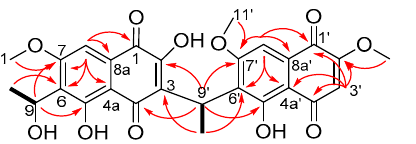
Figure 4. Selected COSY (solid line) and HMBC (arrows) correlations for 1 . The antimicrobial activity of 1 – 3 and 5 was evaluated against a panel of Gram-positive (methicillin-resistant S. aureus ) and Gram-negative ( Pseudomonas aeruginosa , E. coli , K. pneumoniae and Acinetobacter baumanii ) bacteria and two fungal strains ( Candida albicans and Cryptococcus neoformans ) (Table 2). The antimicrobial activity of pramanicin A ( 4 ) was not investigated in the present study due to lack of sample; however, the antifungal activity of the natural product has been previously reported [15]. Both neofusnaphthoquinone B ( 1 ) and monomer 2 exhibited activity against MRSA with 1 exhibiting more potent activity than 2 . Interestingly, during initial ZOI screening, ICMP 21498 (see supporting information) appears equally potent against both S. aureus and E. coli isolates; however, this indiscriminate killing does not appear to have persisted past extraction. It is, therefore, a possibility that several compounds may be responsible for the antibacterial activity of ICMP 21498 and the other compound(s) were not extracted. Table 2. Antimicrobial and antifungal activities of 1 – 3 and 5 .